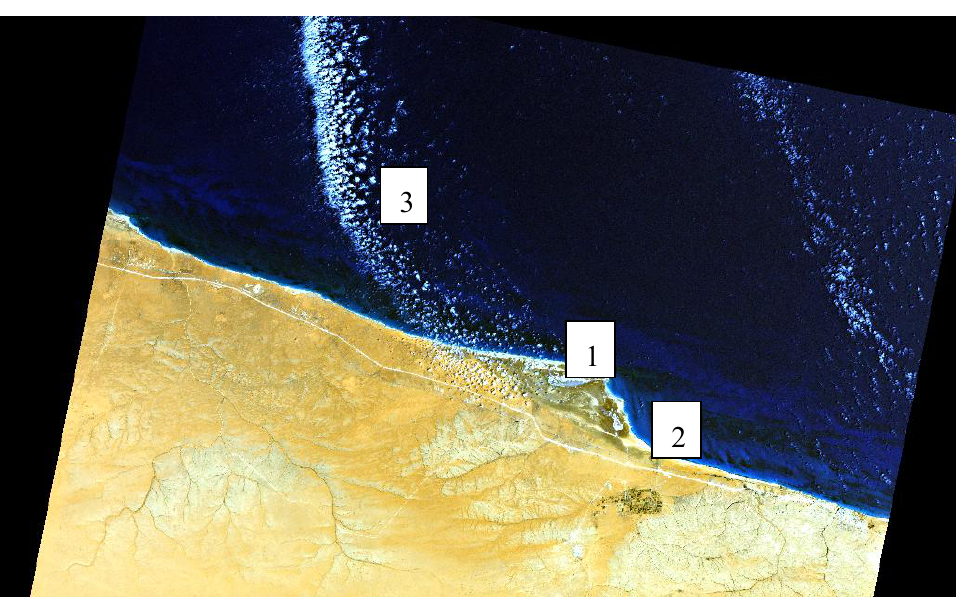
Figure 4 . Coastal scene of Libya, RGB=bands 3, 2,